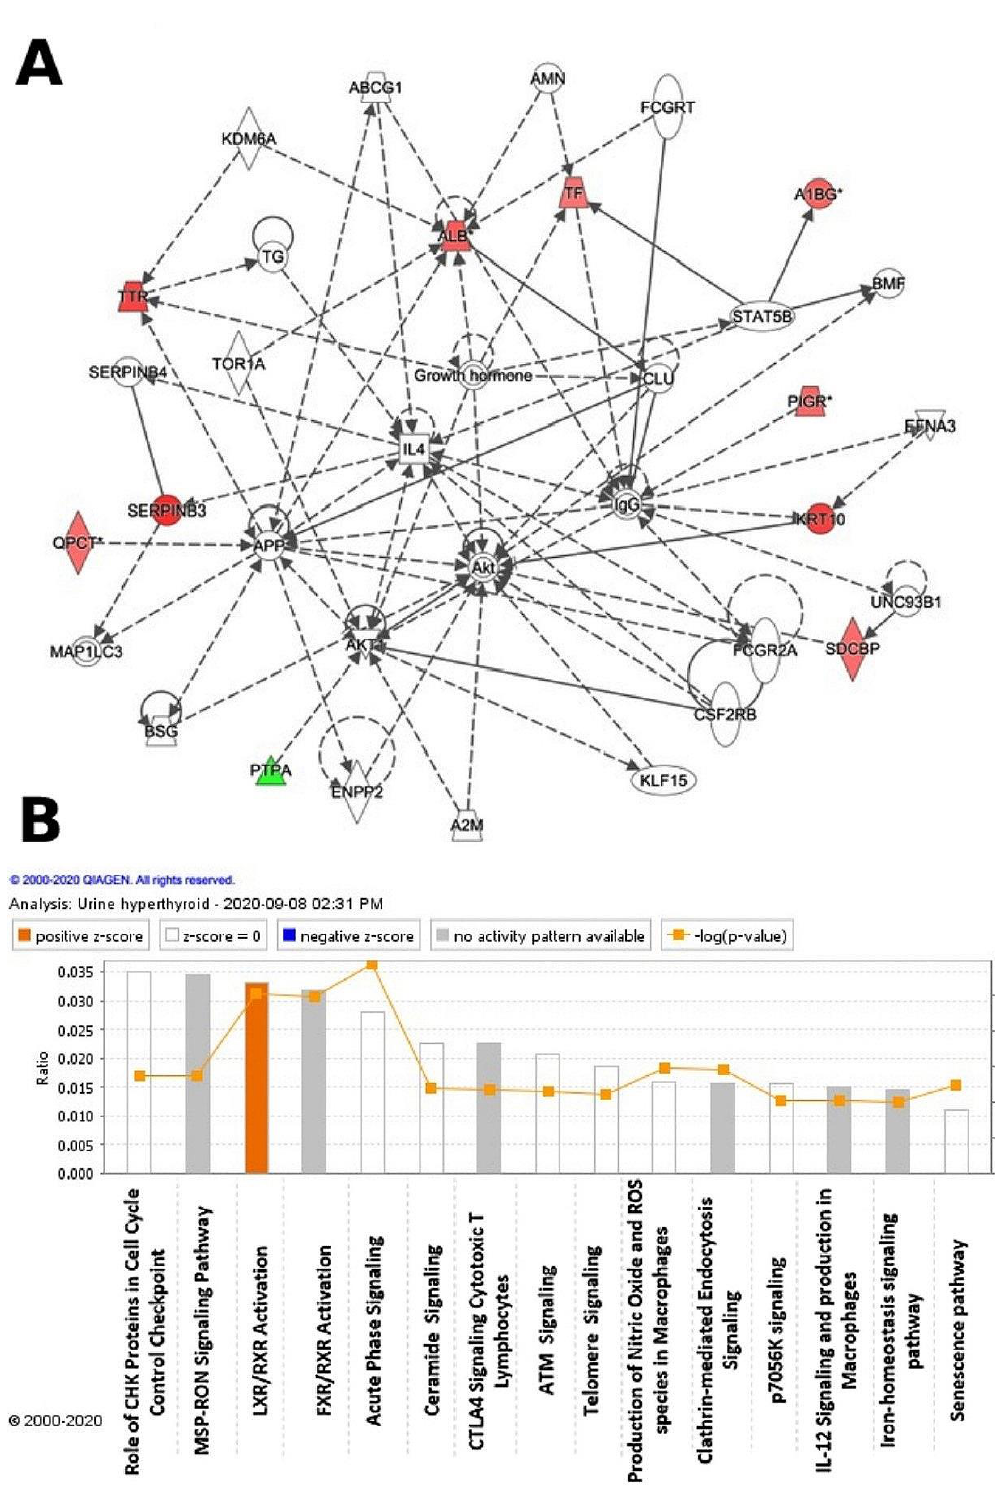
Figure 4. The differentially expressed proteins with their most enriched interaction network in the hyperthyroid state compared with the euthyroid state. Upregulated nodes are red, while downregulated nodes are green. Between the two states, the central nodes of the pathway related to signaling of the ALB, IL4, APP, AKT1, Akt, and IgG were found to be deregulated. IPA proposes uncolored nodes that represent possible targets that were functionally coordinated with the differentially expressed proteins. Direct molecular interactions are indicated by solid lines, while indirect molecular interactions are indicated by dotted lines ( A ). The top 15 canonical pathways, ranked by p -values obtained via the IPA, are depicted in this diagram ( B ).